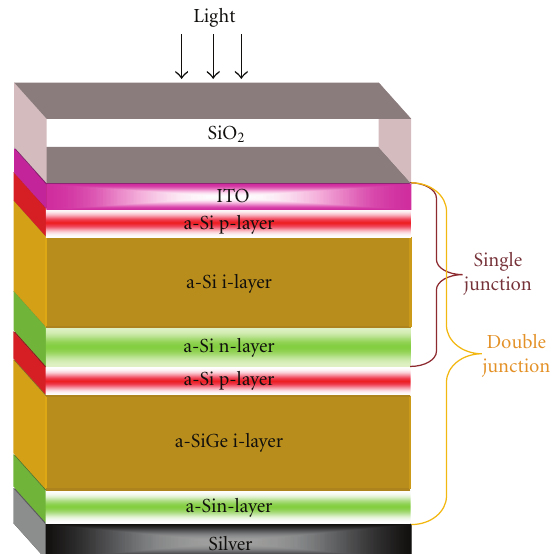
Figure 1: The structure of a double junction and the Layers material of simulated double-junction a-Si:H/a-SiGe:H solar